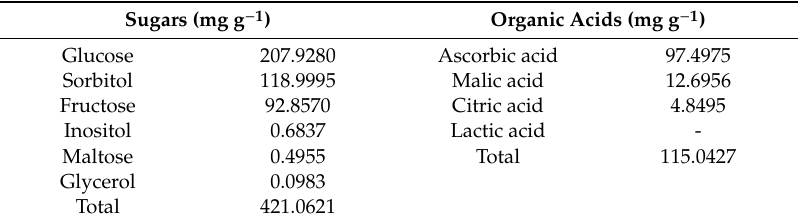
Table 4. Quantification of sugars and organic acids present in black aronia.